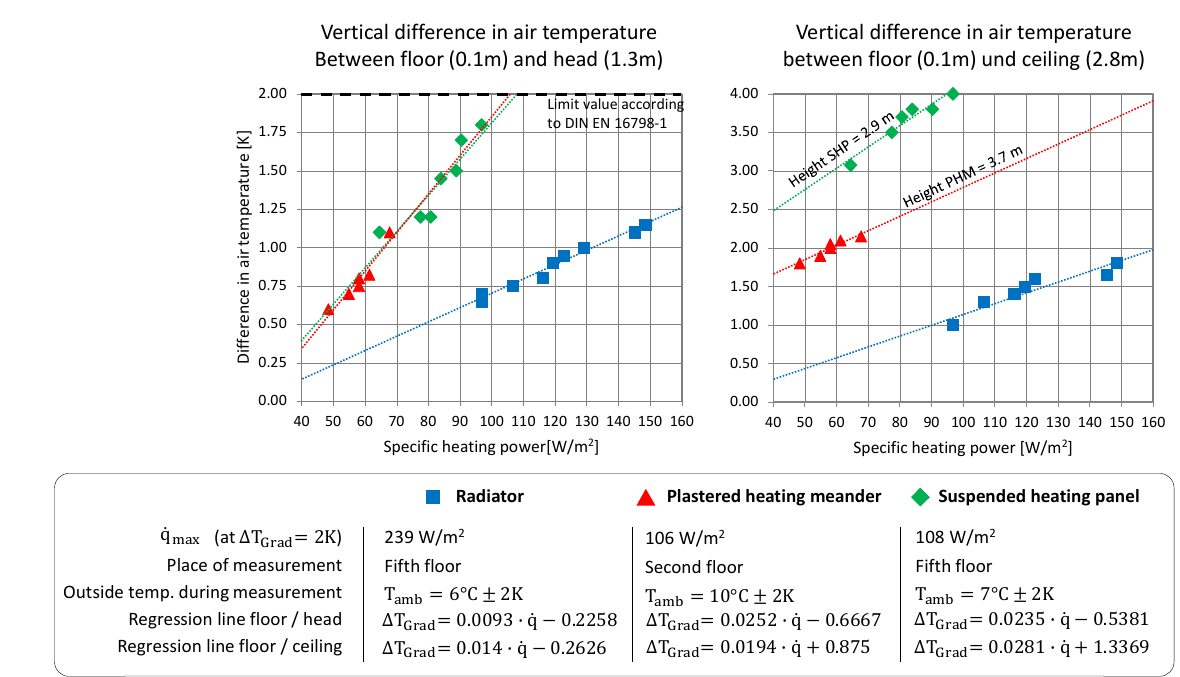
Figure 7. Measured vertical air temperature differences as a function of heating capacity. Table 2. Results matrix for the